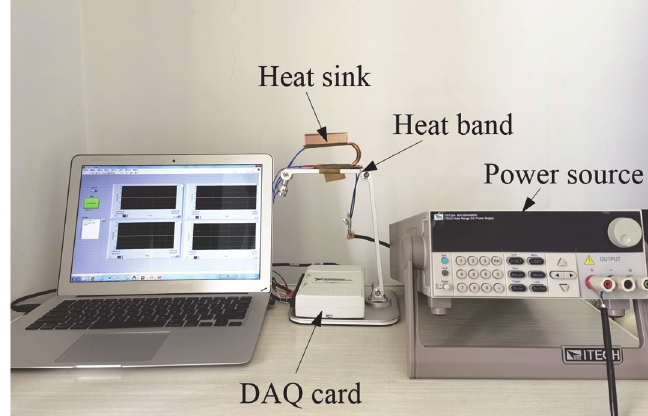
Figure 2. The composition of the heat transfer test platform.